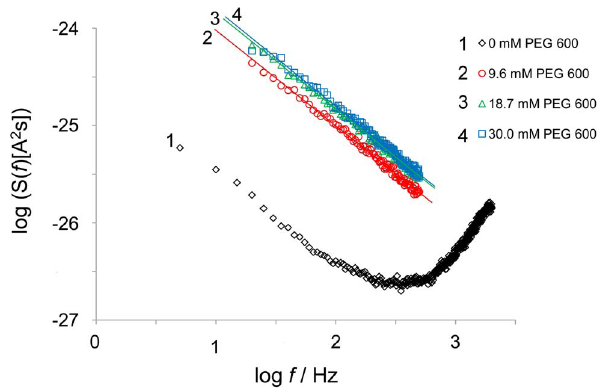
Figure 6. Power density spectrum of PEG 600-induced current noise of 61 P66 channels. Trace 1 shows the control, the aqueous phase contained 1 M KCl. For traces 2, 3 and 4 the aqueous phase contained 9.6 mM, 18.7 mM and 30.0 mM PEG 600, respectively, and the power density spectrum of trace 1 was subtracted from each of those traces. PEG 400- and maltohexaose-induced current noises resulted in similar power density spectra (data not shown).